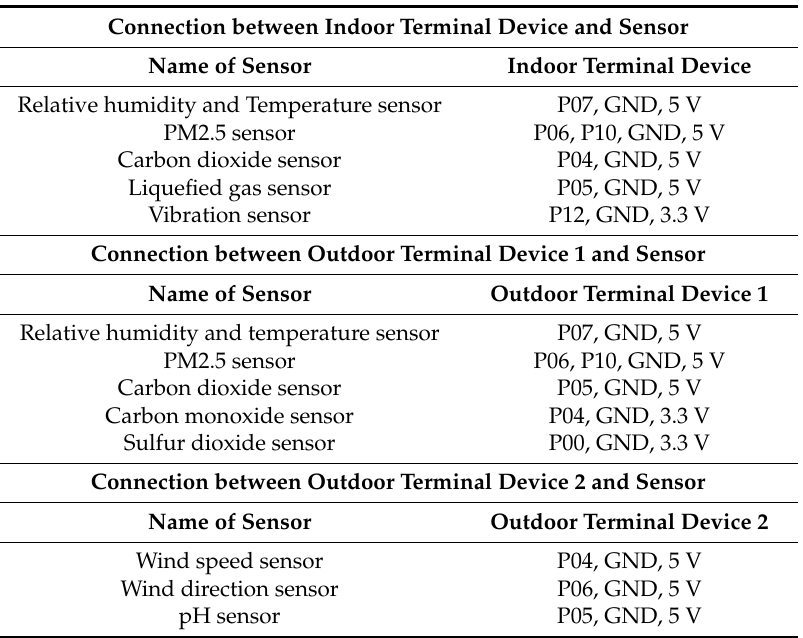
Table 2. The connection between the signal output of the sensor and the signal input of the terminal